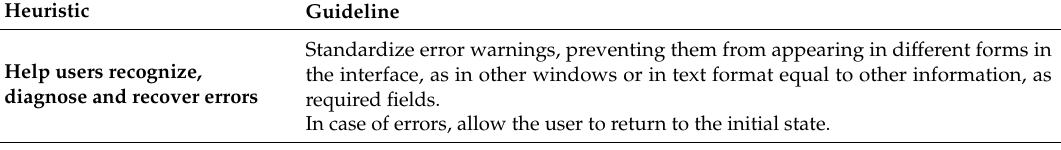
Help users recognize, diagnose and recover errors